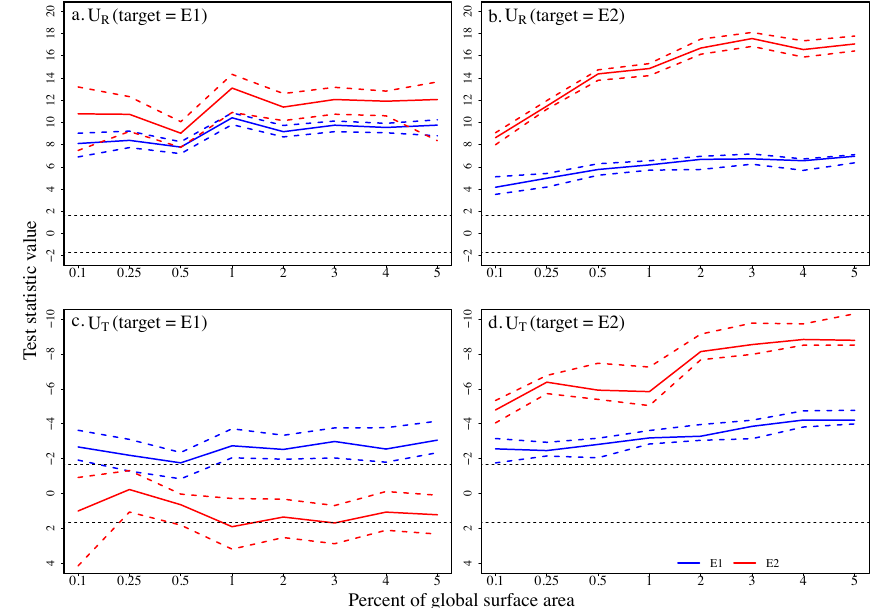
Fig. 7. As Fig. 6, but for the E1 (blue) and E2 (red) ensemble averages.